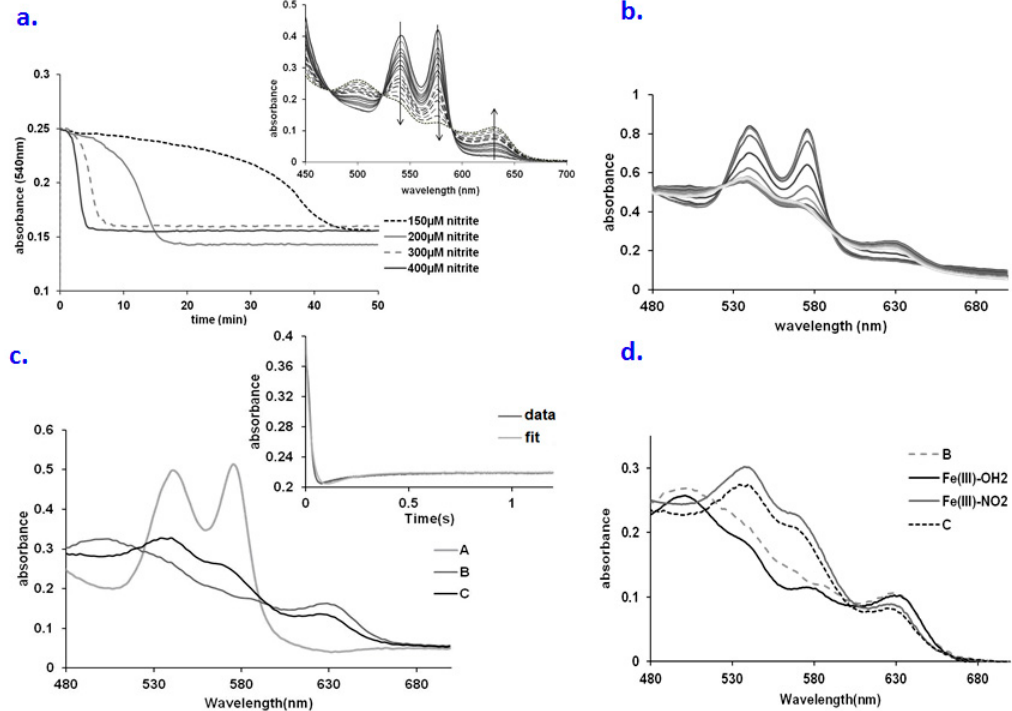
Figure 1. ( a ) Time courses for the nitrite oxidation of hemoglobin in oxygen-saturated phosphate buffer saline (PBS) buffer at various concentrations of nitrite. Conditions: 25 µM Hb, PBS 7.4, room temperature; ( b ) UV-vis spectra collected upon mixing oxyHb (66.6 µM) with NaNO 2 (660 mM). Conditions: pH 7.4, PBS buffer, aerobic, over a range of 2 s; ( c ) Computed spectra for the species